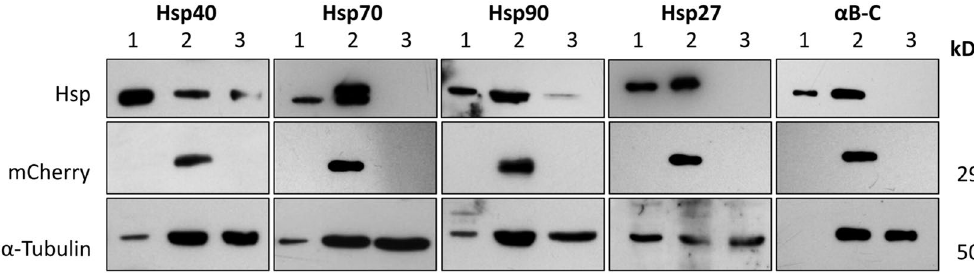
Figure 1. Immunoblot analysis of Hsp and mCherry expression in Neuro-2a cells transfected with one of the Hsp-encoding pIRES2 bicistronic constructs. Neuro-2a cells transfected with one of the Hsp-encoding bicistronic constructs were sorted by FACS such that a population of mCherry + ve cells were purified and whole cell lysates equivalent to 100,000 cells were loaded into each well. The membranes were probed for α -tubulin (50 kDa), mCherry (29 kDa) and Hsp40, Hsp70, Hsp90, Hsp27, and α B-c. Protein samples analysed were